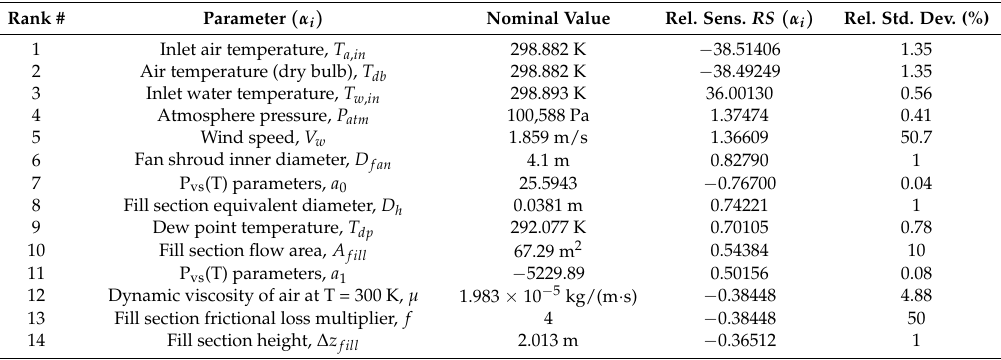
Table 6. Most important relative sensitivities of the air mass flow rate, m a